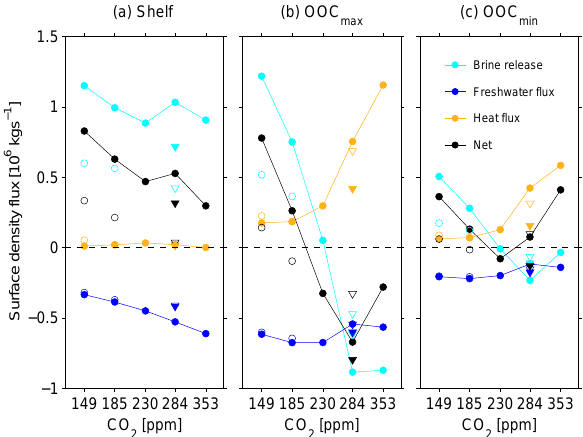
Figure 11. Components of the annual mean density flux integrated over different regions of the Weddell Sea as a function of p CO 2 integrated over (a) the shelf area defined by the 1000m isobath, (b) the open-ocean convection area defined by the maximum ex- tent of MLD > 2000m from all experiments and (c) the open-ocean convection area defined by the minimum extent of MLD > 2000m from all experiments. Positive values indicate a density gain, and negative values indicate a density loss. The x axis is scaled loga- rithmically. Open symbols indicate the experiments with reduced brine release. Circles indicate the LGM-nnn experiments, and the triangles represent the piORB experiments.